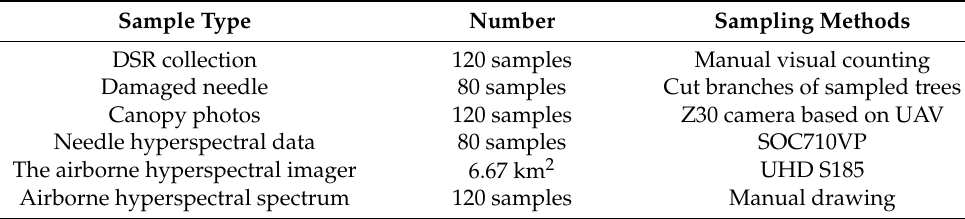
Table 3. Summary of experimental